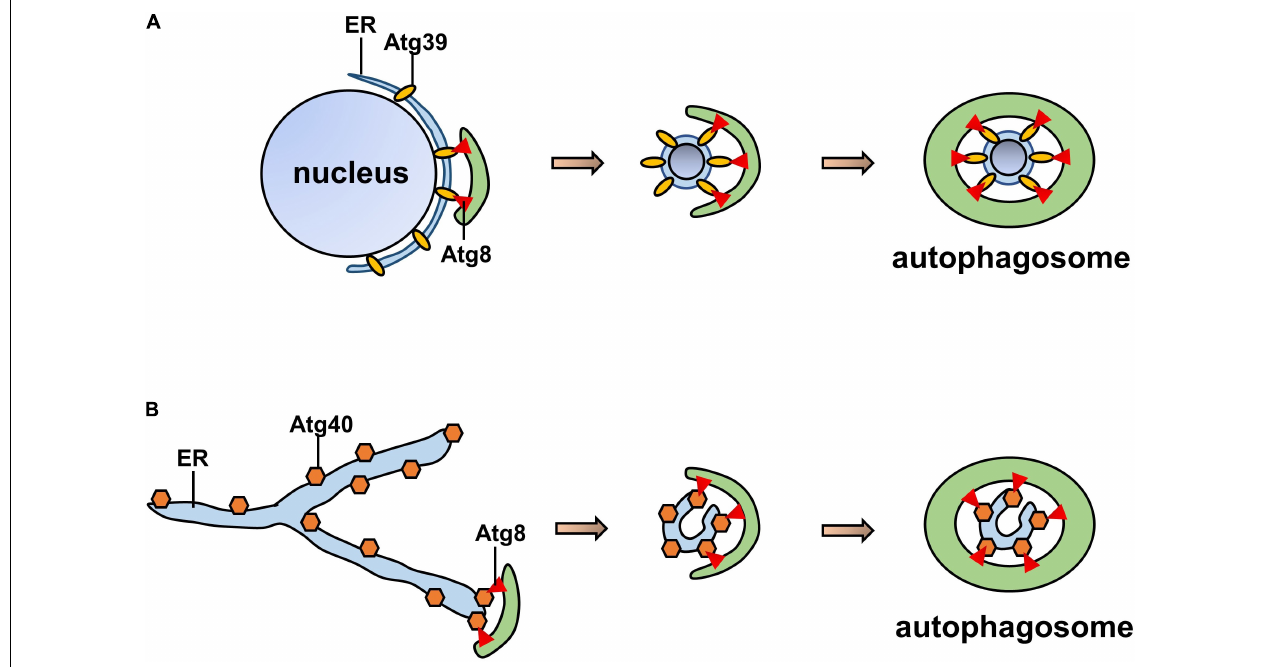
FIGURE 3 | Pattern of ATG39/40-dependent ER-phagy. (A) ATG39-dependent ER-phagy of the perinuclear ER. (B) ATG40-dependent cortical and cytoplasmic ER-phagy. Both ATG39 and ATG40 contain AIMs that interact with ATG8 to form autophagosomes.